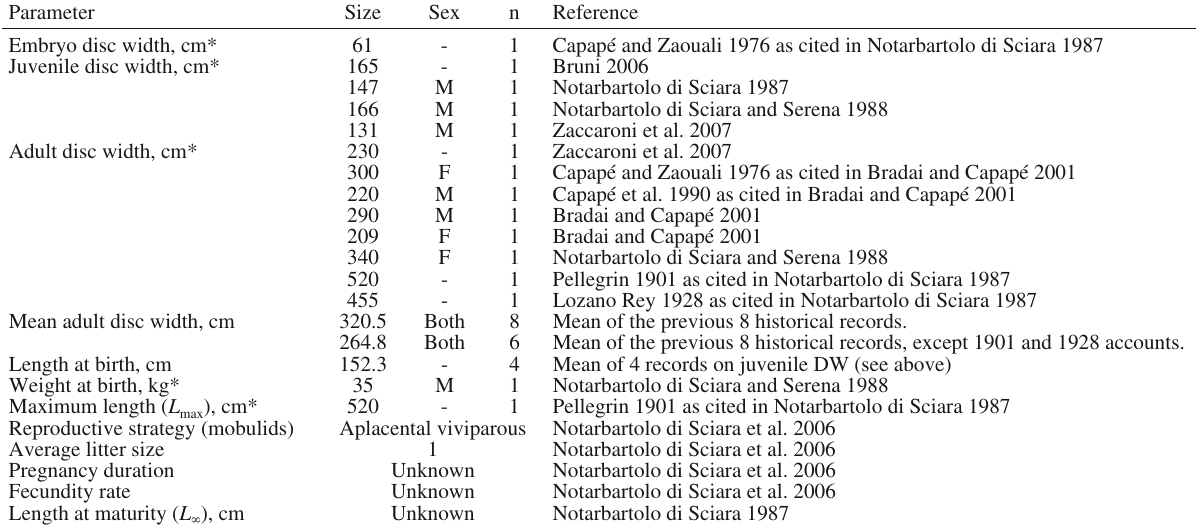
estimates or rough measures/estimates.